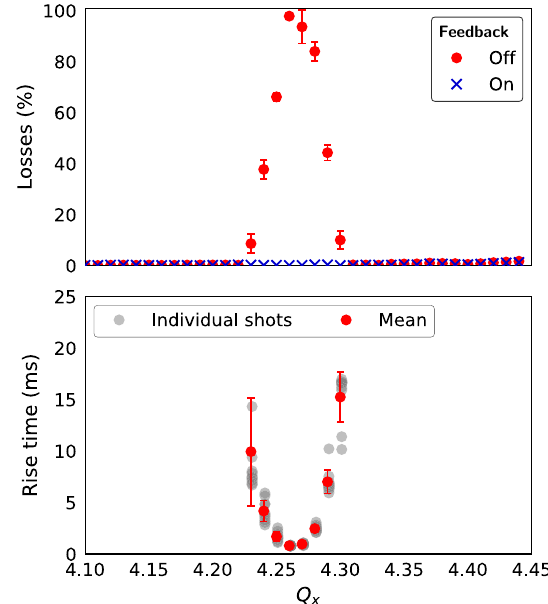
FIG. 3. Measured beam losses (upper plot) and instability rise time (bottom plot) versus Q x for 2 × 10 12 p. Losses reach almost 100% when the TFB is off with a maximum at Q x ¼ 4 . 26 , when the rise time is as fast as 0.6 ms (the revolution period is 1 μ